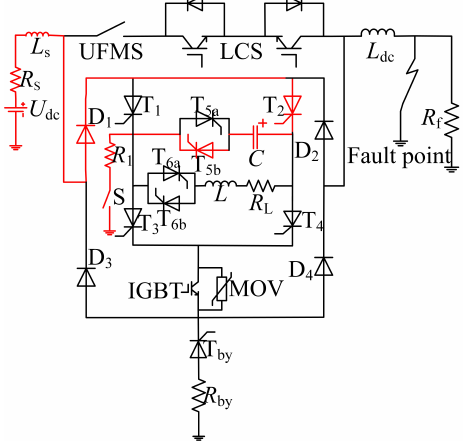
Fig. 2. Capacitor C pre-charge circuit diagram The function of the large resistor R 1 is to limit the value of the charging current. When the capacitor C is